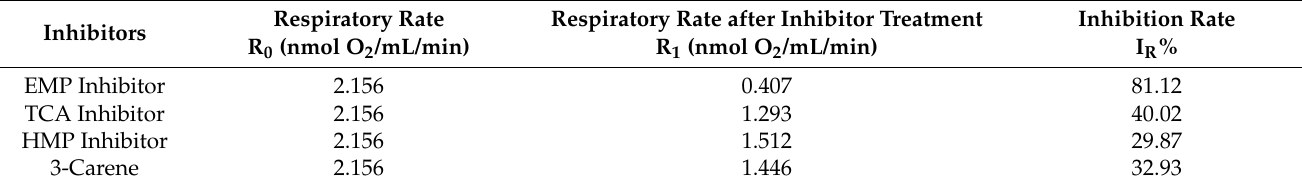
Table 2. Inhibition rates of three representative inhibitors and 3-carene on P. lundensis